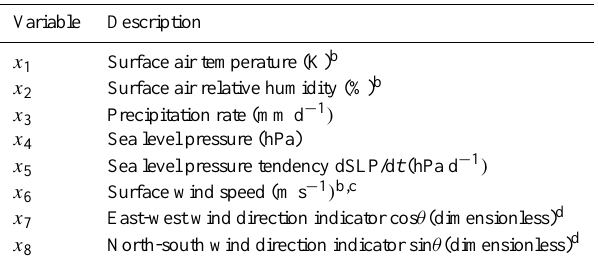
Table 1. Variables used to define meteorological modes for PM 2 . 5 variability a .